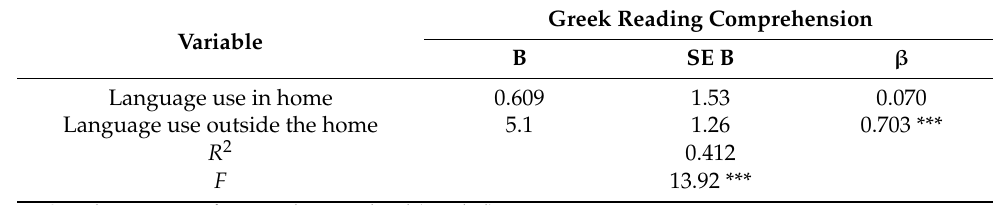
Table 9. Summary of multiple regression analysis for contextual variables predicting children’s performance on reading comprehension in Greek (N =